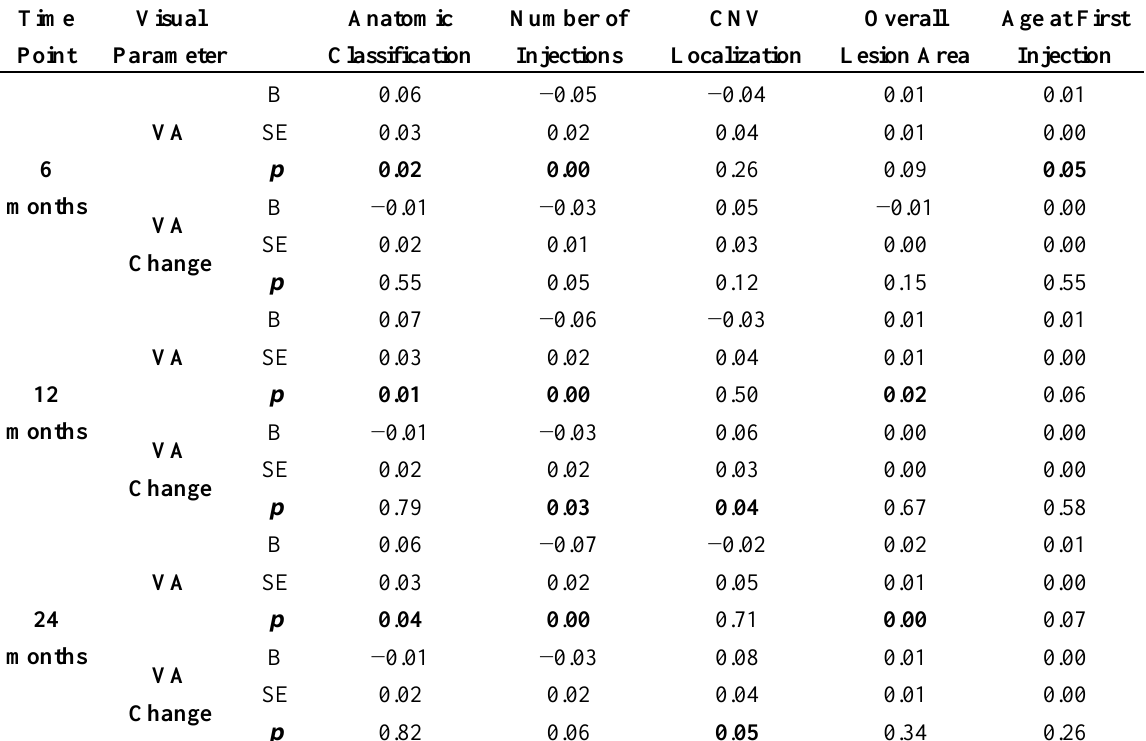
Table 4. Multivariate analysis of visual acuity and visual acuity change using baseline clinical parameters over